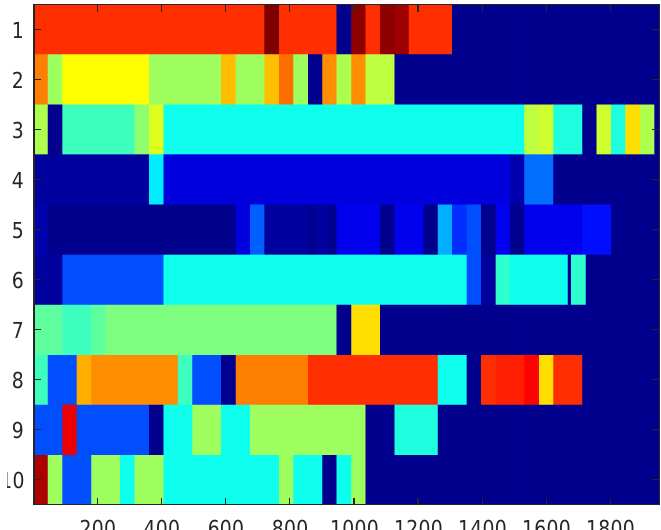
Figure 9. Motion clustering results for brushing teeth. The x-axis designates frame numbers (at 30 Hz). The y-axis designates participants’ IDs. Motions belonging to the same cluster have the same color. The plot shows how different subjects perform the same activity very differently while many motions repeat among multiple subjects